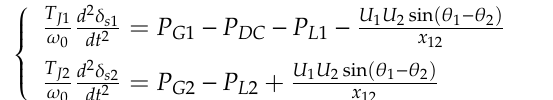
Figure 2. Equivalent model of AC/DC interconnected system.